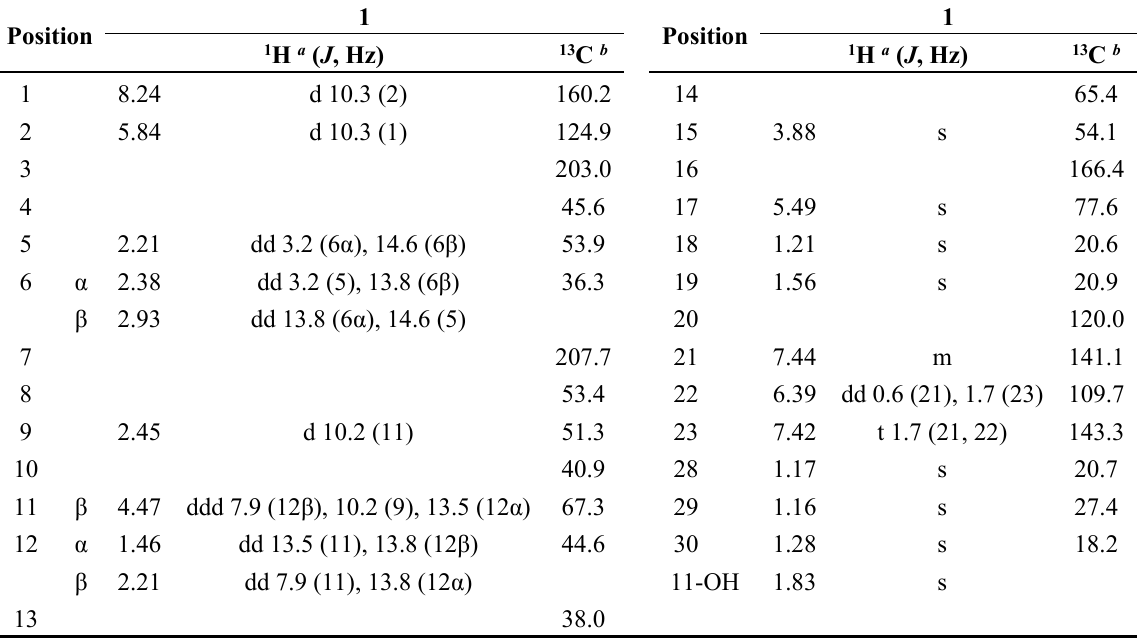
b Measured at 150 MHz in CDCl 3 ;